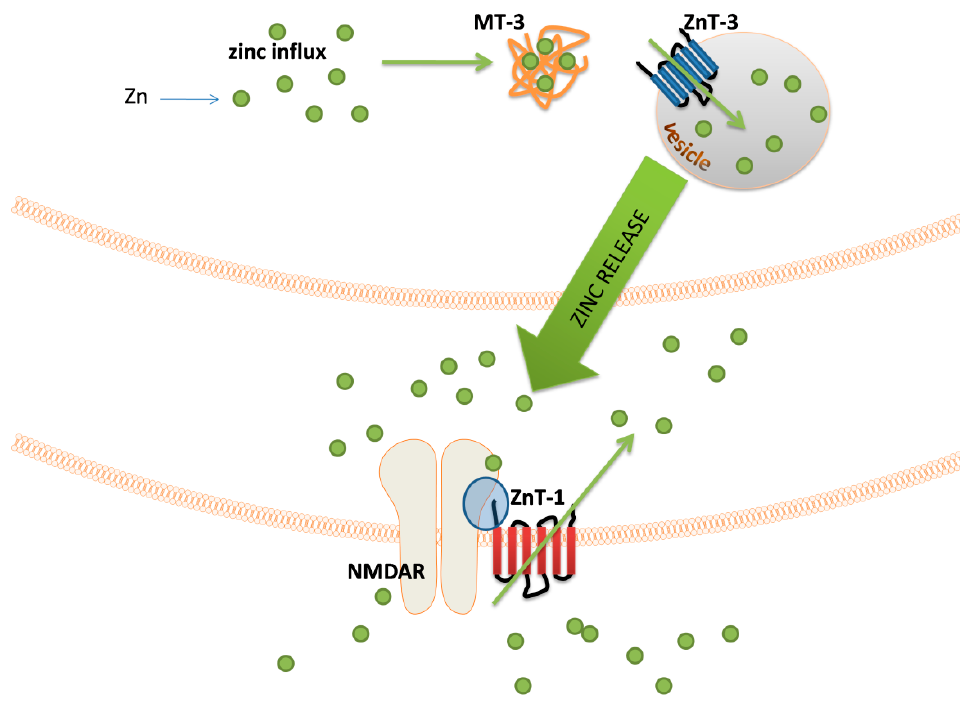
Figure 3. Schematic representation of the events related to the zinc signal release from zincergic synapses. After zinc influx, Zn 2 + ions are bound by metallothionein 3 (MT-3). This protein delivers zinc to the zone where vesicles are formed. The influx of Zn 2 + into the vesicle is catalyzed by ZnT-1 transporter. After release, Zn 2 + appears in a synaptic cleft and di ff uses through it. This phenomenon leads to the interaction of Zn 2 + with postsynaptic N-methyl-D-aspartate glutamate receptor (NMDAR) and the influx of these ions into the postsynaptic nerve terminal. The level of Zn 2 + in a postsynaptic neuron is regulated by the ZnT-1 transporter responsible for e ffl ux of Zn 2 + excess. The location of ZnT-1 in the membrane allows this transporter to interact with the GluN2A subunit of NMDAR (blue